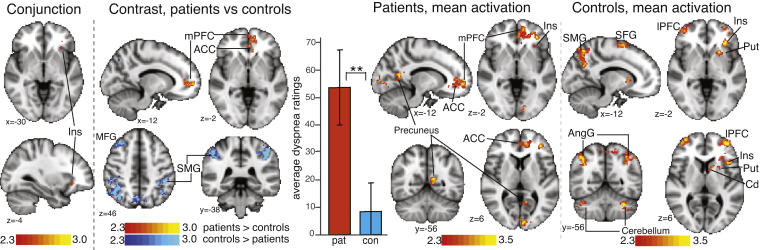
Brain responses to dyspnoea word cues in patients and matched controls (reproduced with permission from Herigstad et al., 2015). Activation (contrasts and conjunction) correlating with visual analogue scale ratings to dyspnoea word cues. Maps are whole-brain analysis, cluster level corrected for multiple comparisons at p < 0.05. Maps represent conjunction analysis (activations common to both groups) and comparisons between groups, (patients > controls in red–yellow, controls > patients in blue–lightblue), and mean activations in patients and controls. Bar graph is average ± SD dyspnoea ratings for each group. mPFC (medial prefrontal cortex), ACC (anterior cingulate cortex), Ins (insula), Pcun (precuneus cortex), SMG (supramarginal gyrus), SFG (superior frontal gyrus), ACC (anterior cingulate cortex), AngG (angular gyrus), cerebellum (CrusI and VI) (For interpretation of the references to colour in this figure legend, the reader is referred to the web version of this article.).